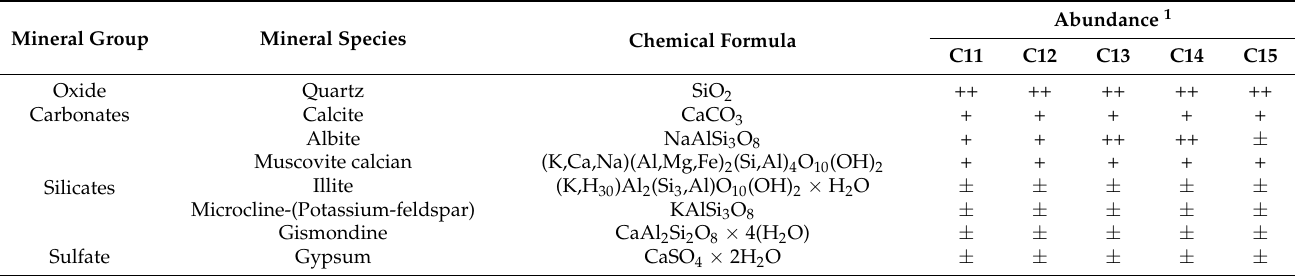
Table 5. Powder X-ray diffraction results of the silty soil samples (<150 µ